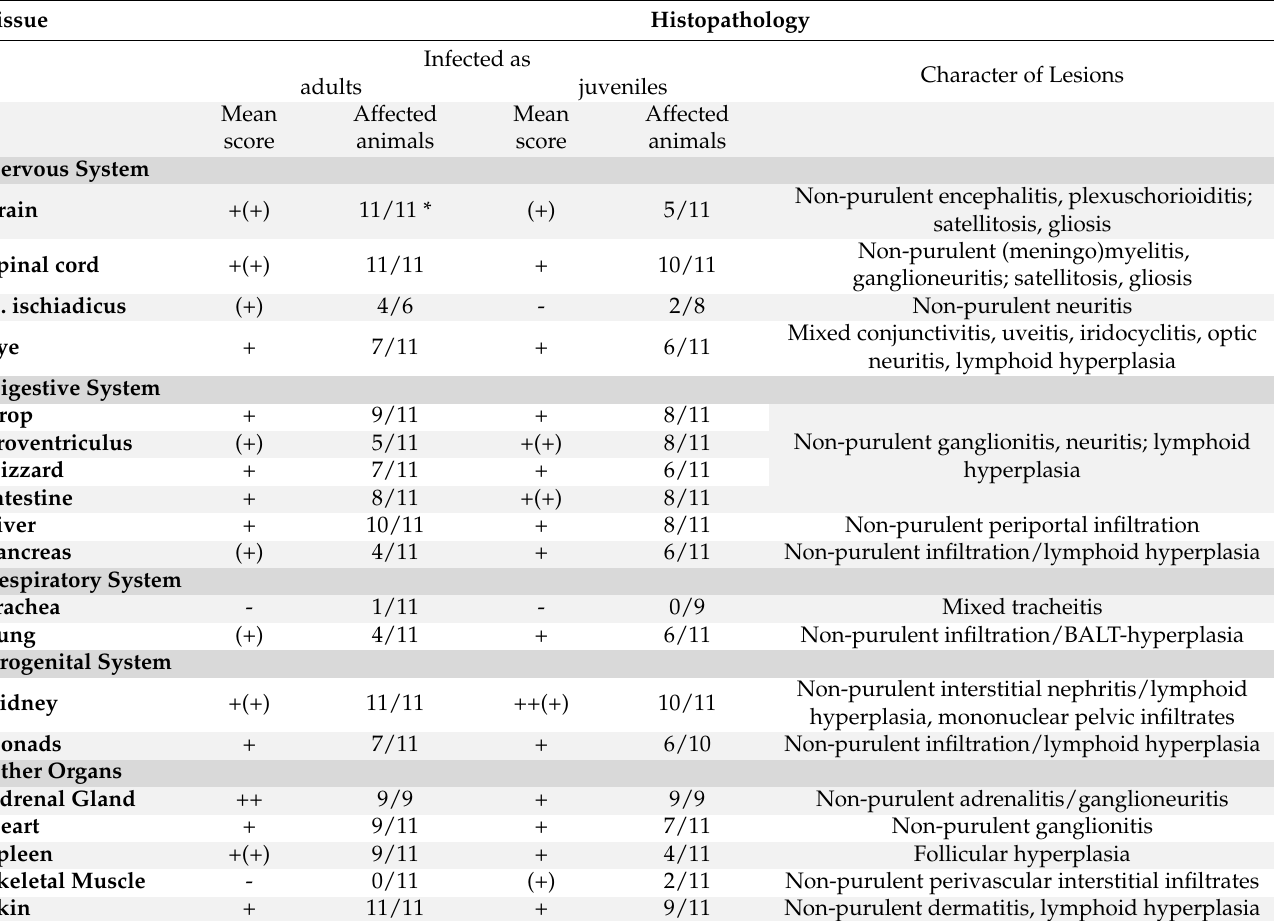
Table 2. Overview of histopathologic changes in 11 adult- and 11 juvenile-PaBV-4 infected